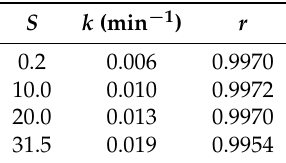
Table 7. Dynamics fitting of nano-Al 2 O 3 sedimentation in ASW with different salinity. S k (min − 1 ) r 0.2 0.006 0.9970